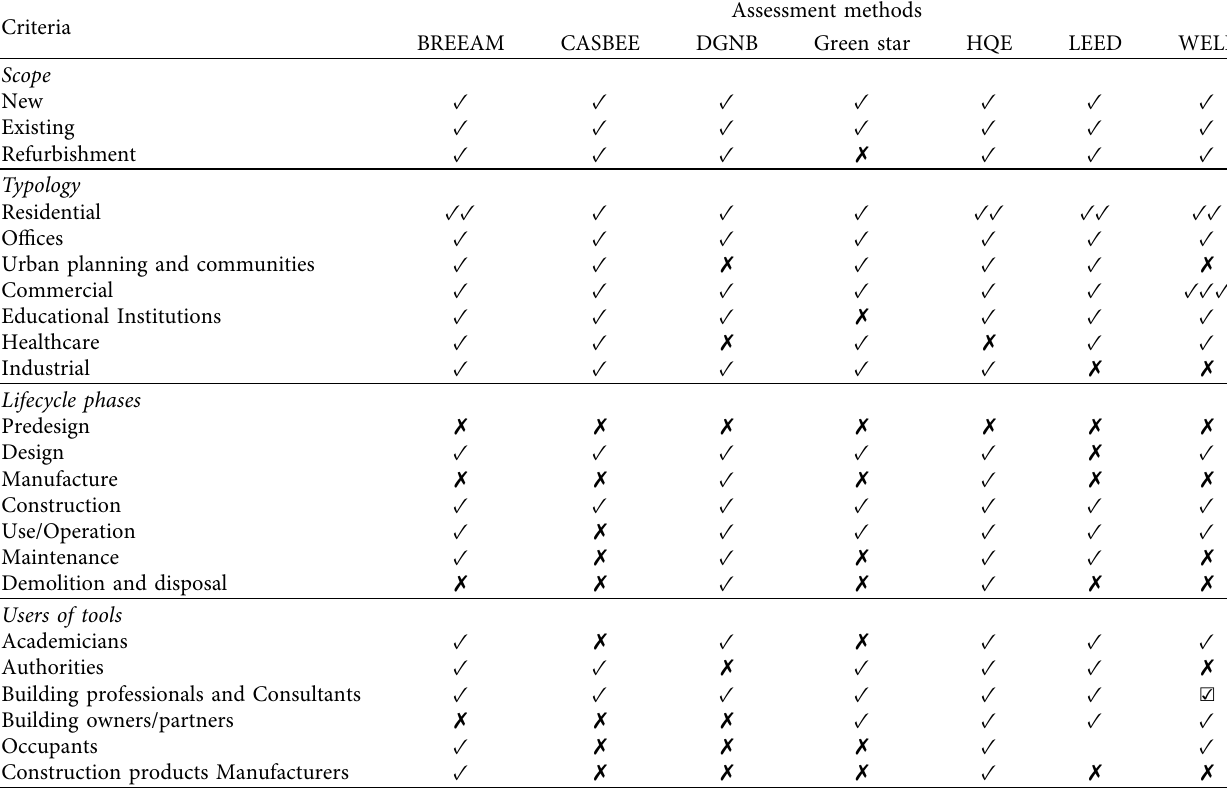
Table 5: Criteria considered for comparison.